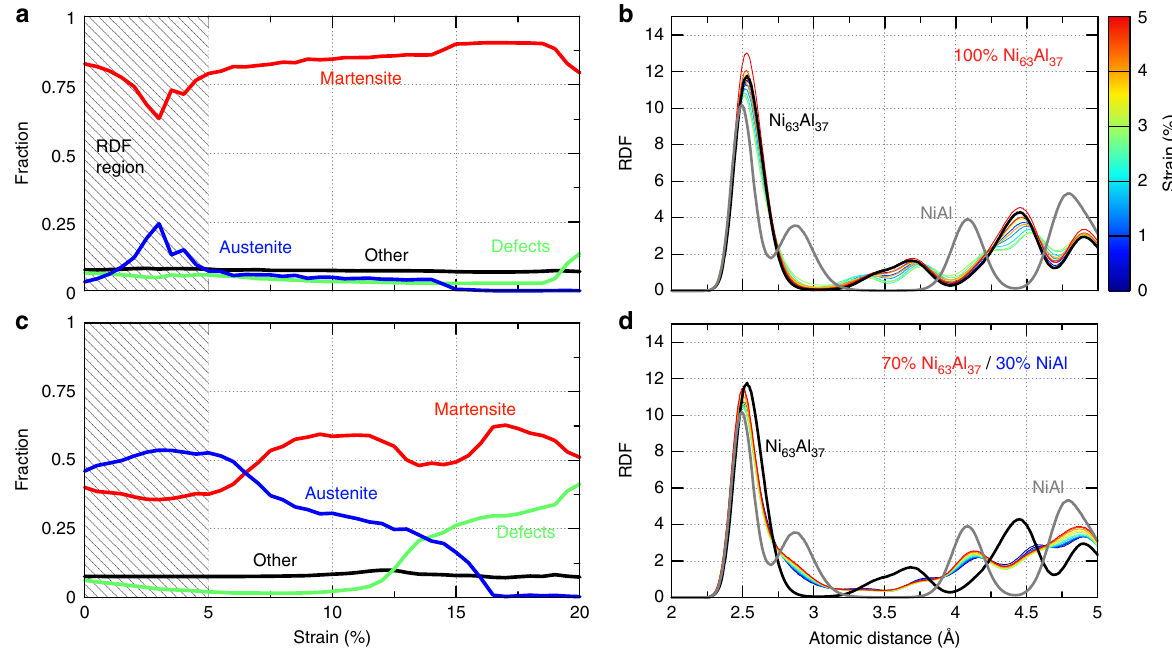
Fig. 4 Structural analysis contrasting homogeneous and metamaterial nanowires. a CNA shows the homogeneous Ni 63 Al 37 nanowire is almost entirely martensite through 20% uniaxial strain with a temporary, sharp increase in austenite during nucleation of a new domain orientation. b This results in moderate changes in the RDF up to 5% strain. Shading for CNA indicates region shown in atomic structures (Fig. 3) and RDF. RDF for unstrained homogeneous Ni 63 Al 37 and NiAl nanowires in black and gray, respectively. c 70 at% T-Shell metamaterial nanowire CNA exhibits phase coexistence with smooth switching between martensite and austenite. d The metamaterial RDF lies between the individual phases, with signi fi cant peak broadening, which changes only slightly with